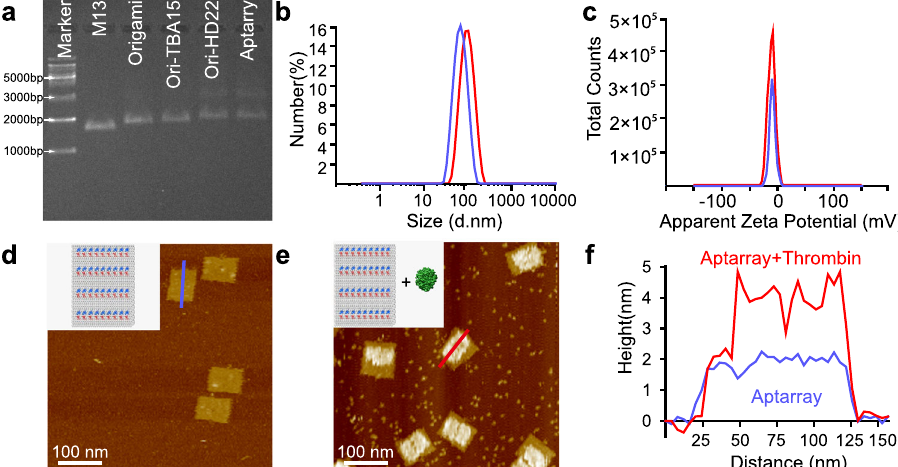
Fig. 2 Characterization of DNA origami-based aptamer nanoarray. a Ethidium bromide-stained agarose gel image of the step-by-step assembly of DNA origami-aptamer nanoarray. Lane 1: Marker. Lane 2: M13 genome DNA (M13). Lane 3: rectangular DNA origami template with capture strands (Origami). Lane 4: DNA origami-TBA15 nanostructures (Ori-TBA15). Lane 5: DNA origami-HD22 nanostructures (Ori-HD22). Lane 6: DNA origami-aptamer nanoarray (Aptarray). b Hydrodynamic sizes and c Zeta potentials of DNA origami template (blue) and Aptarray (red). d AFM image of bivalent aptamer arrays on the DNA origami (36 TBA15, blue; 36 HD22, red; the four double rows of aptamers with distances of 5.4 nm between aptamer types). e Thrombin incubation with the Aptarray illustrated in panel d . The large areas of bright spots on the surface of the rectangular origami represent the bound thrombin molecules. Scale bars, 100 nm. f The heights of origami-based aptamer nanoarrays (blue, Aptarray; panel d ) and thrombin bound structures (red, Aptarray + Thrombin; panel e ) were measured by AFM. The gel image ( a ) and AFM graphs ( d , e ) are representative of three independent experiments. Source data are provided as a Source Data fi number of TBA15 and HD22 on each DNA origami sheet was these DNA nanostructures increased from 63.0 ± 1.2 nm (bare calculated to be 33.5 ± 0.4 and 32.4 ± 1.1, respectively. The size origami, blue) to 92.2 ± 1.3 nm (Aptarray, red) after the and the zeta potentials of nanoparticles are important parameters hybridization of the two aptamers (Fig. 2b). The zeta potentials to affect their behaviors in vitro and in vivo. Dynamic light of DNA origami and Aptarray were − 12.2 ± 0.8 mV and − 10.9 ± scattering (DLS) analysis showed that the average diameters of 1.1 mV, respectively (Fig. 2c). AFM images show the successful